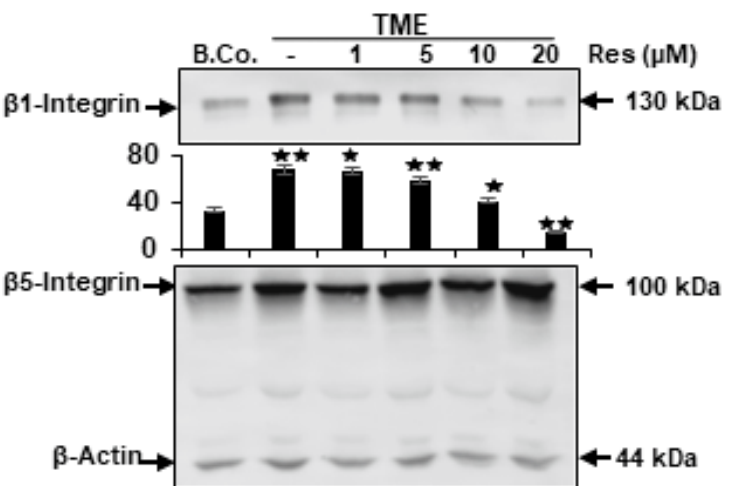
Figure 2. The impact of resveratrol on TME-triggered expression of β 1- and β 5-integrin. HCT116 cells in alginate matrix in basal control (B. Co.) or in TME were untreated or TME treated with diverse dosages of resveratrol (1, 5, 10, 20 µ M) for 10–14 days as outlined in Materials and Methods. Immunolabeling of cell lysates was conducted by Western blotting with antibodies against β 1- and β 5-integrin. Data are originated from three separate assays, and β -actin was used as a reference. Y -axis: densitometric units confirming Western blot results. * p < 0.05, ** p < 0.01 compared with TME control.